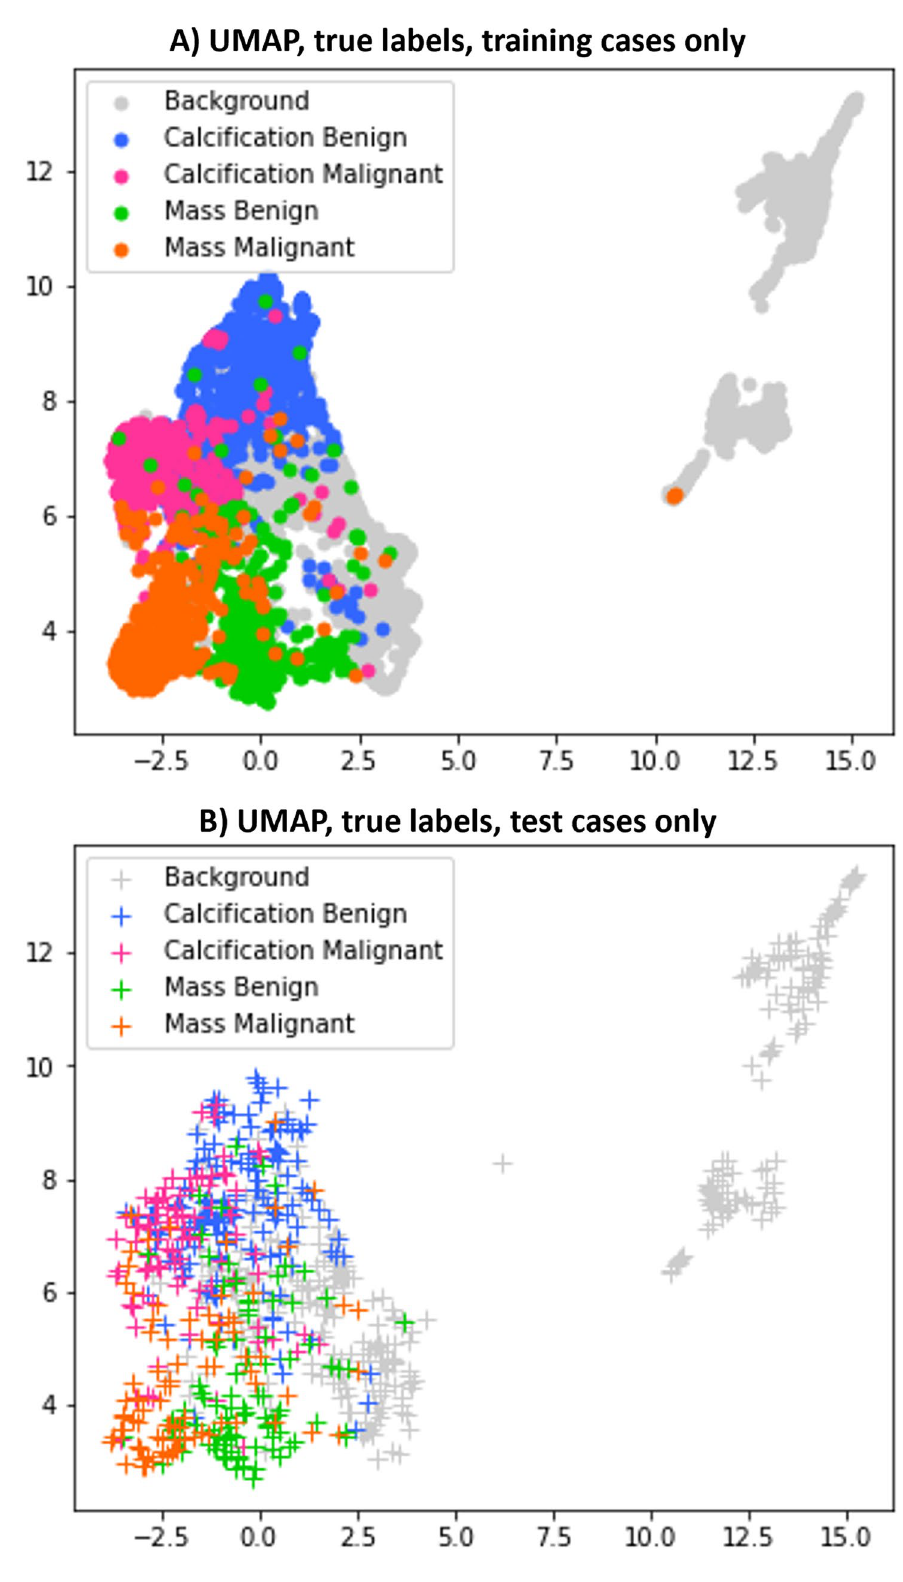
Figure 3. Visualisation using supervised UMAP. Supervised UMAP is applied to the set of extracted convolutional features. As in Fig. 2, data points represent patient mammograms, which are colour-coded by their assigned label. ( A ) shows only the training data; ( B ) only the test